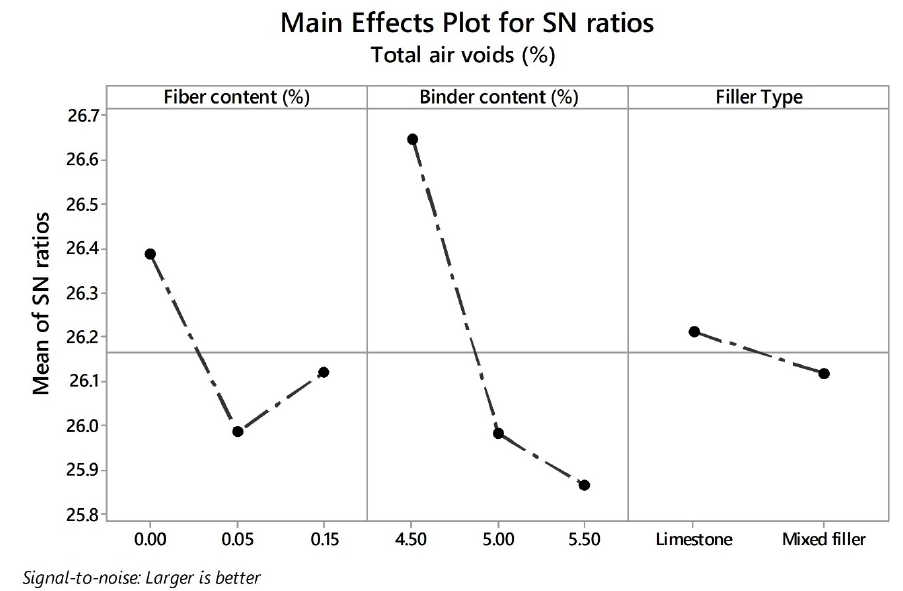
Materials 2020 , 13 , 675 Figure 6. Effects of parameters on mean signal-to-noise (SN) ratios for (cid:1846) (cid:3002)(cid:3023) . Figure 6. E ff ects of parameters on mean signal-to-noise (SN) ratios for T